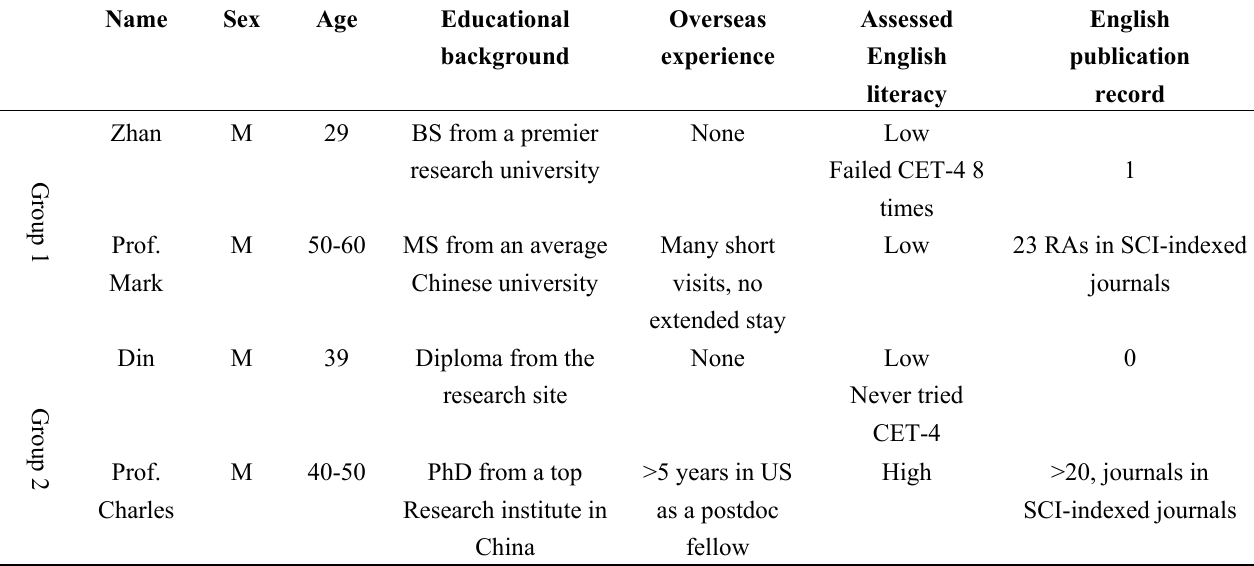
Table 1. Demographic information of the student participants and their supervisors. Name